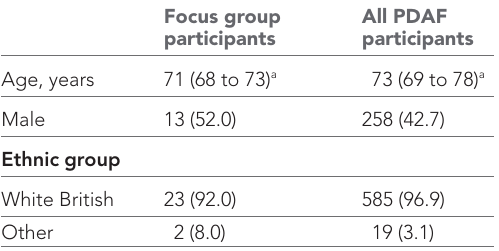
Table 1 Comparison of focus group and